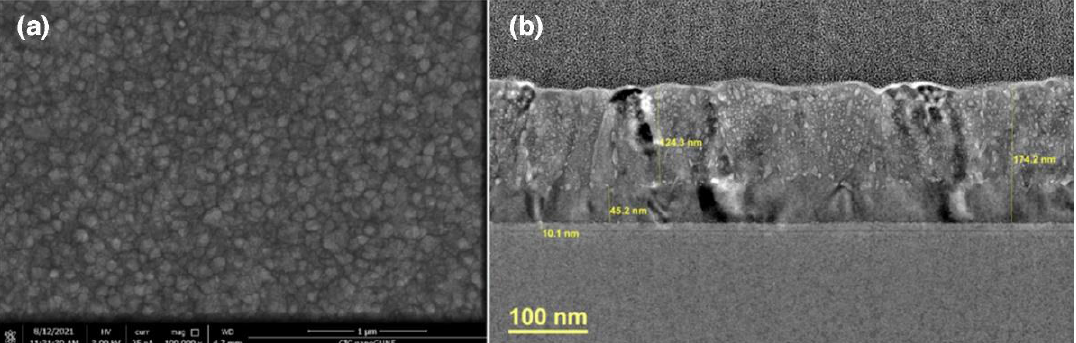
Figure 5. Surface SEM ( a ) and cross-sectional HRTEM ( b ) images of a coated-glass fabricated from an inorganic-organic thin film composed of TiO 2 layers (prepared by TiCl 4 /H 2 O ALD) and hybrid Ti/HQ layers (prepared by TiCl 4 /HQ MLD) (2:8 pulse sequence) after annealing under optimized conditions.